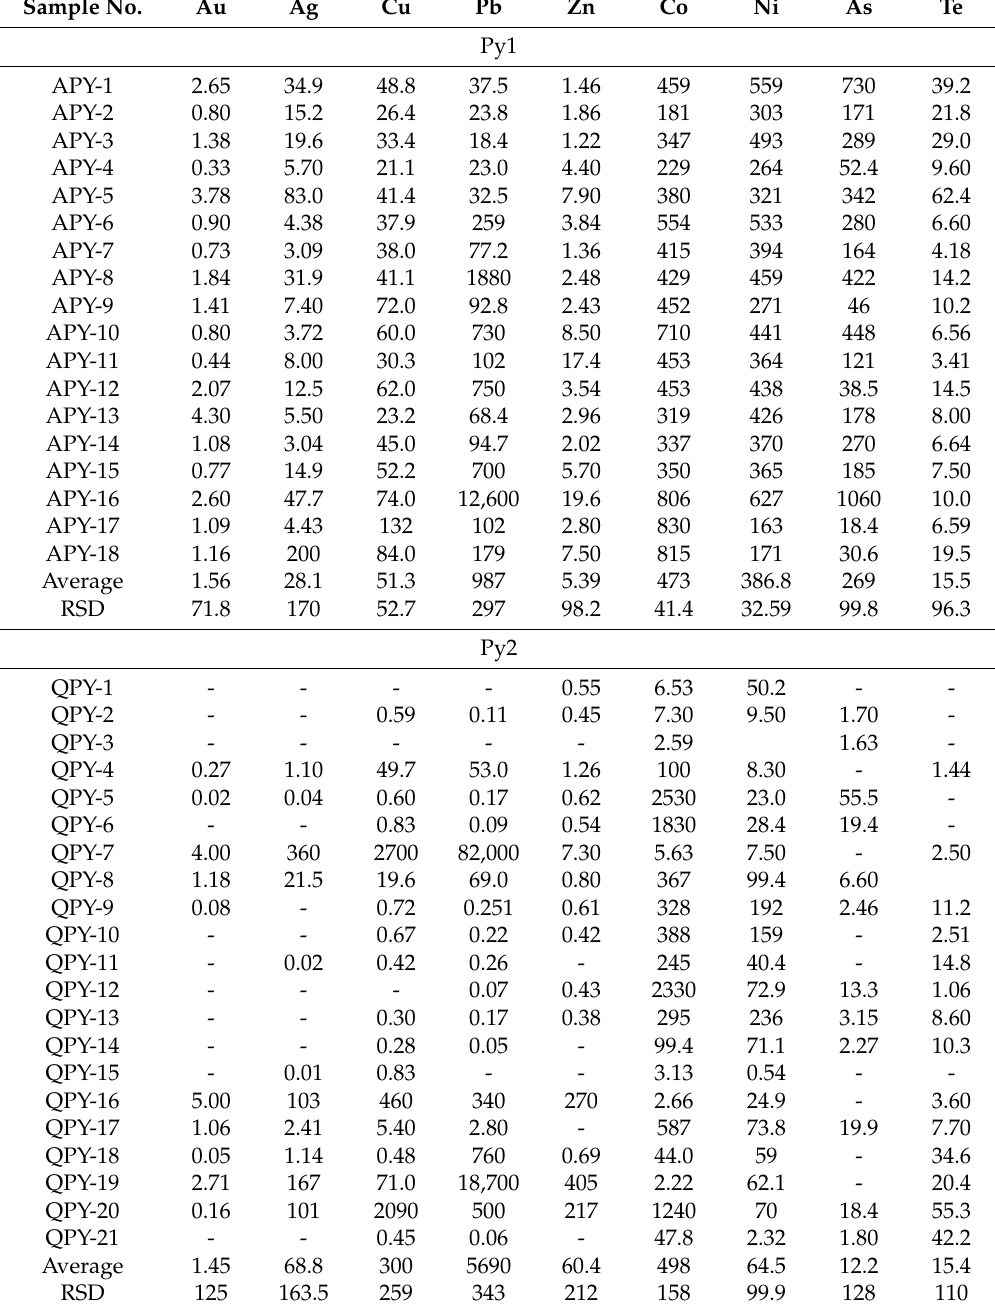
Table 1. LA-ICP-MS results for pyrites from the Huanxiangwa gold deposit. Sample